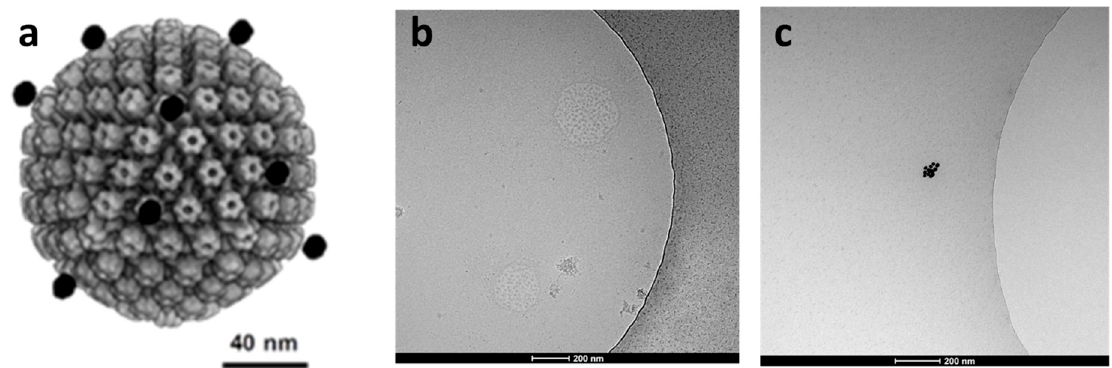
Figure 5. ( a ): Hypothetical interaction of Au nanoparticles • and HSV-1 virion (HSV-1 model adapted from [36]). ( b ): Cryo-TEM of HSV-1 treated with AuNP 10 nm particles (1 h incubation time), ( c ): AuNP 10 nm particles .